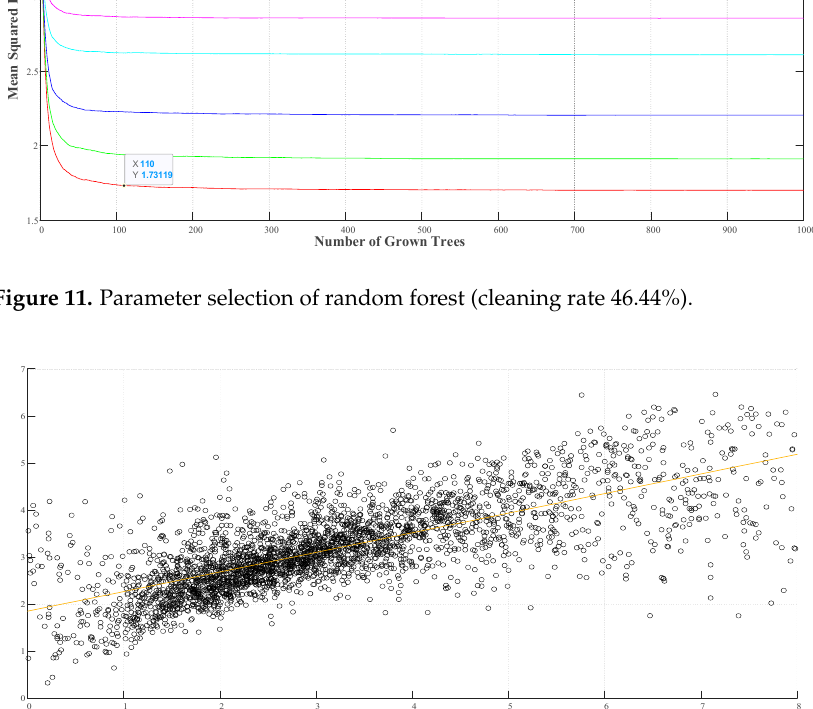
Figure 12. Calculation results based on random forest (cleaning rate 46.44%). 4.4. Analysis Based on Improved Random Forest in Lower Cleaning Rate When the cleaned sample data as the original data is fed into the modi fi ed random forest algorithm model, as shown in Figure 13, the leaf node number is set to 5, while the number of decision trees is 75, and optimum RMSE is 1.2639. The calculated value and observed value of test samples are distributed in Figure 14. Obviously, there is a linear correlation between the model calculated value and the ob- served value. The correlation coe ffi cient is 0.6733. Excellent linear correlation features ap- pear both in the high distribution density range of [1, 5] and the low distribution density